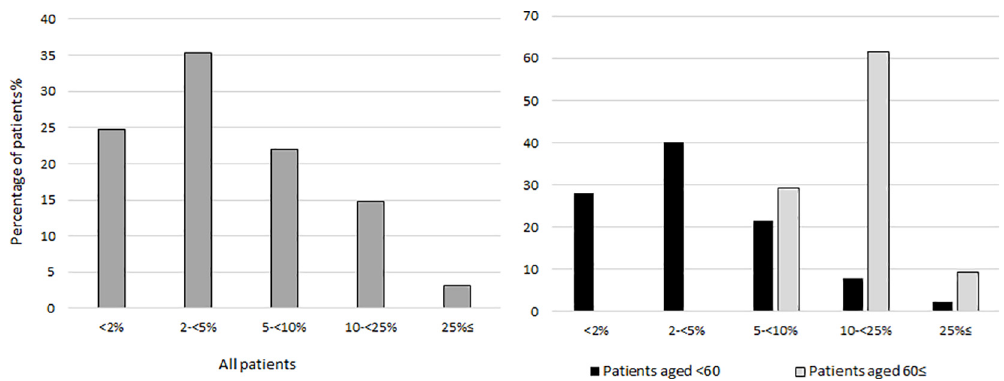
Fig 1. Frequency distribution of patients grouped by five-year mortality risk, overall and by age-group.